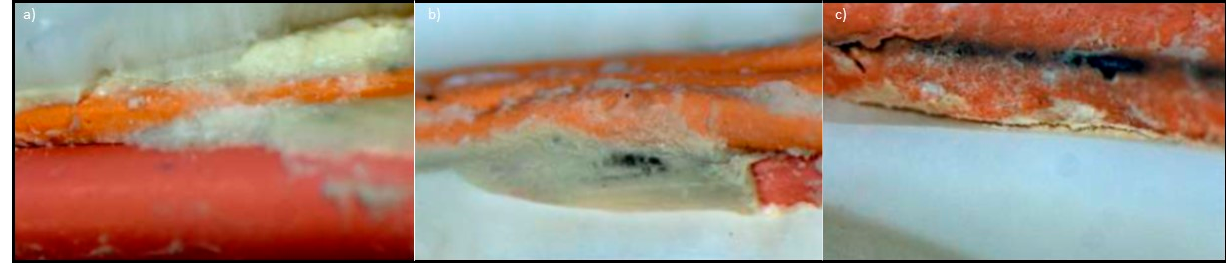
Figure 14. Middle section of the sealed root canal. ( a , b ) Cold: ( a ) thick intermediate layer of sealant on the border of the dentin of the root canal and complementary studs, and a thick intermediate layer of sealant on the border of complementary cones and central cone with visible leakage; ( b ) a thick intermediate layer of sealant covering the centre stud and additional studs adjacent to the main stud; ( c ) thermoplastically condensed—leakage on the border of the sealant and dentin, viewed with LSM.